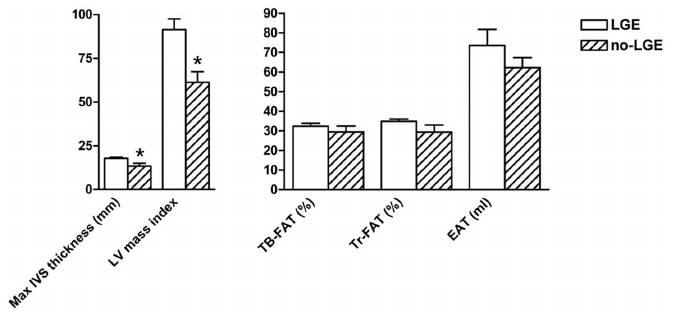
Fig 2. Cardiac parameters on CMR and regional fat distribution in subjects with and without LGE. Abbreviations: CMR, cardiac magnetic resonance; EAT, epicardial adipose tissue; IVS, interventricular septum; LGE, late gadolinium enhancement; LV, left ventricle; TB, total body; Tr, truncal. Data are presented as mean ± SD. * p < 0.05.